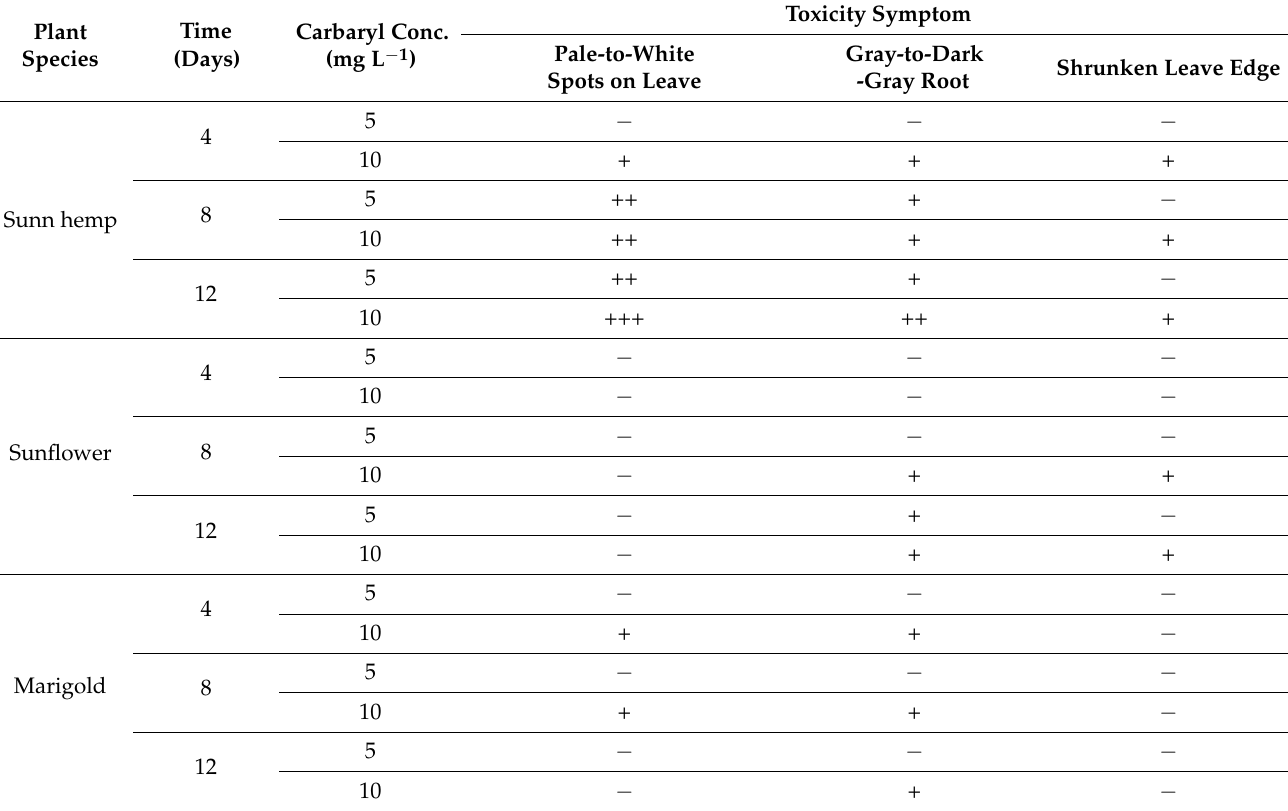
Table 1. Toxicity symptoms were observed in plants exposed to carbaryl for 4, 8, and 12 days 1